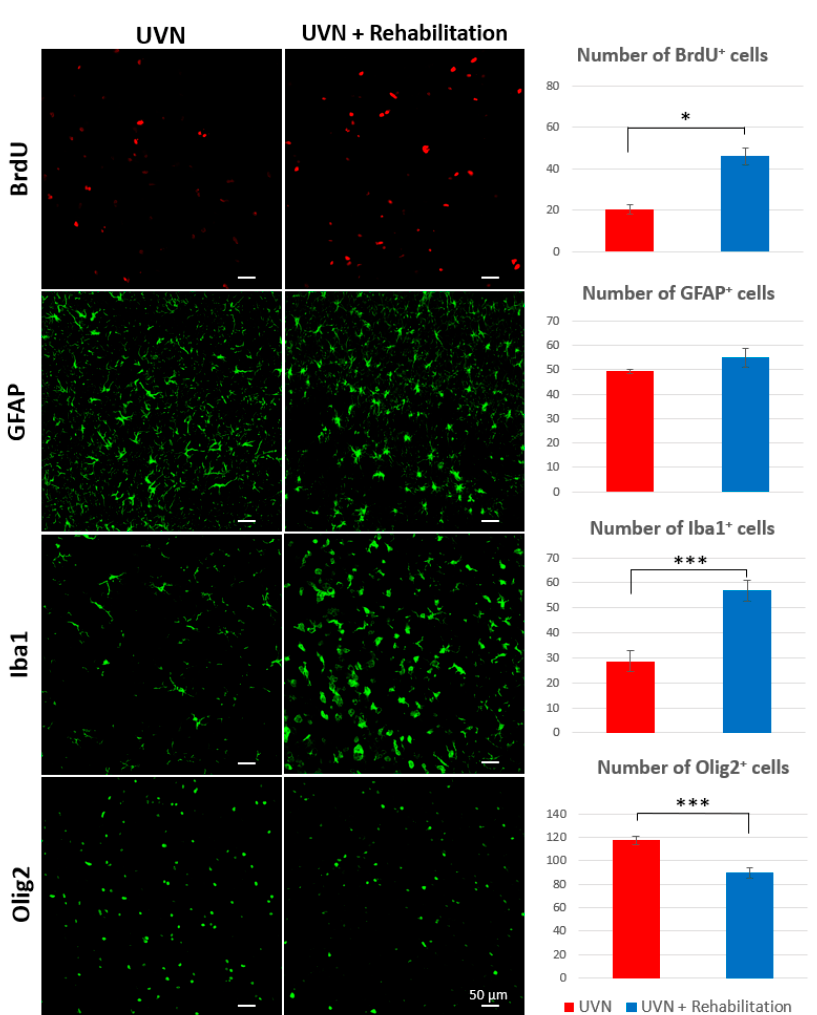
Figure 6. Cell population counts in the medial vestibular nucleus of rats in the UVN and rehabilitation groups 30 days after injury. BrdU injection 3 days after injury was used to analyse cell survival in the compensated phase of the vestibular syndrome. On the left are images of immunohistochemical staining taken with a confocal microscope. The newly generated cells (BrdU + ) are marked in red. Green labelling highlights astrocytes (GFAP + ), microglia (Iba1 + ), and oligodendrocytes (Olig2 + ). On the right side of the figure are histograms showing the number of immunoreactive BrdU, GFAP, Iba1, and Olig2 cells. Compared to the UVN group, the rehabilitation group had significantly more BrdU + cells ( p < 0.05), more microglial cells ( p < 0.001), and fewer oligodendrocytes ( p < 0.001).